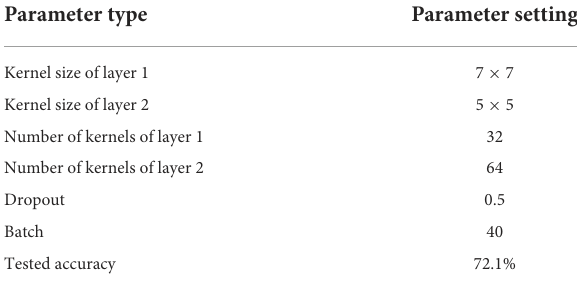
TABLE 11 Optimal combination of parameters for CNN